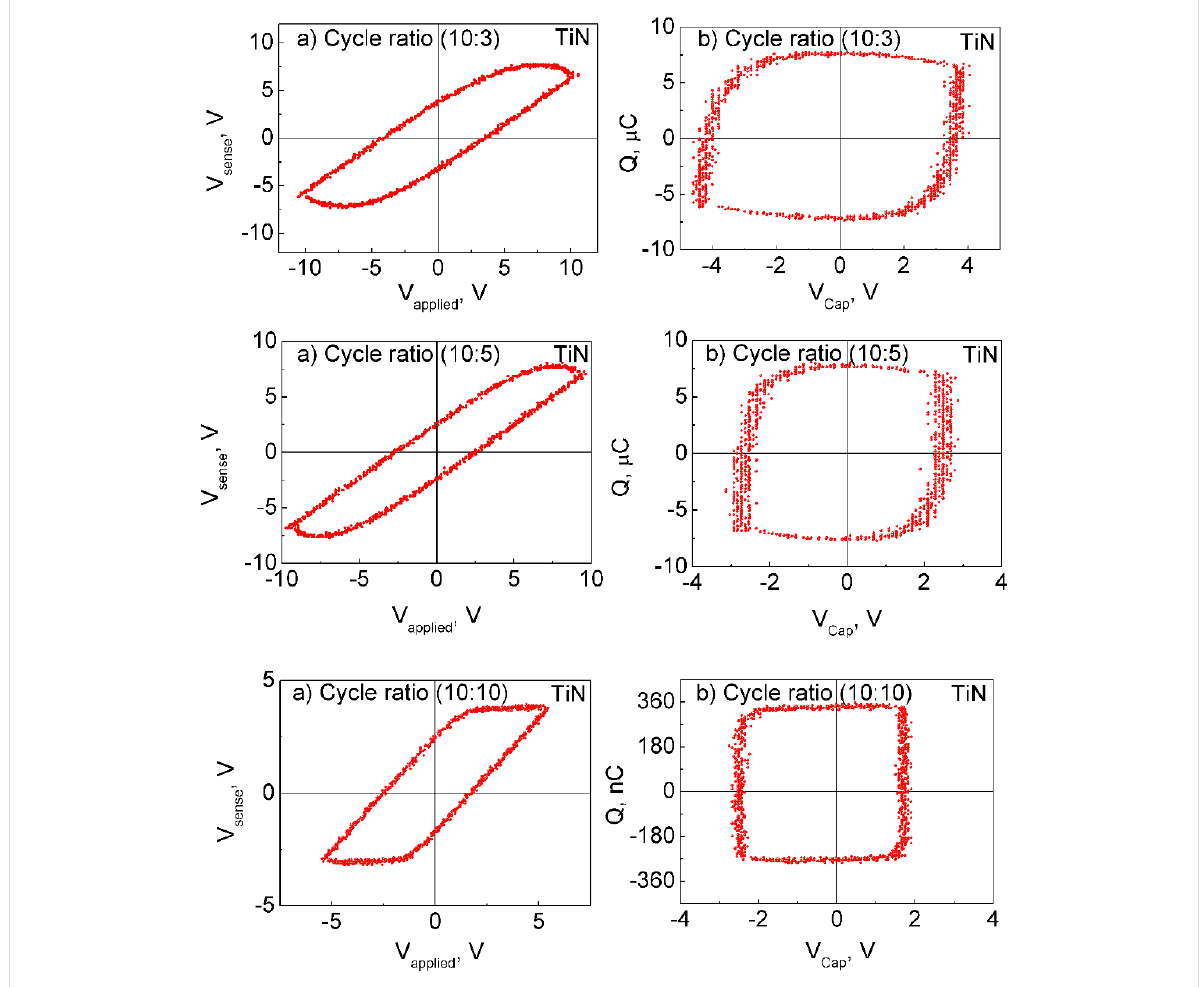
Figure 6: Each of the three panels show a sensed voltage–applied voltage curve on the left (a) and a polarization charge–applied voltage curve on the right (b) for Pt/ZrO 2 /Fe 2 O 3 /TiN/Ti/Si(100)/Al samples. ZrO 2 /Fe 2 O 3 cycle ratios are shown on each image.